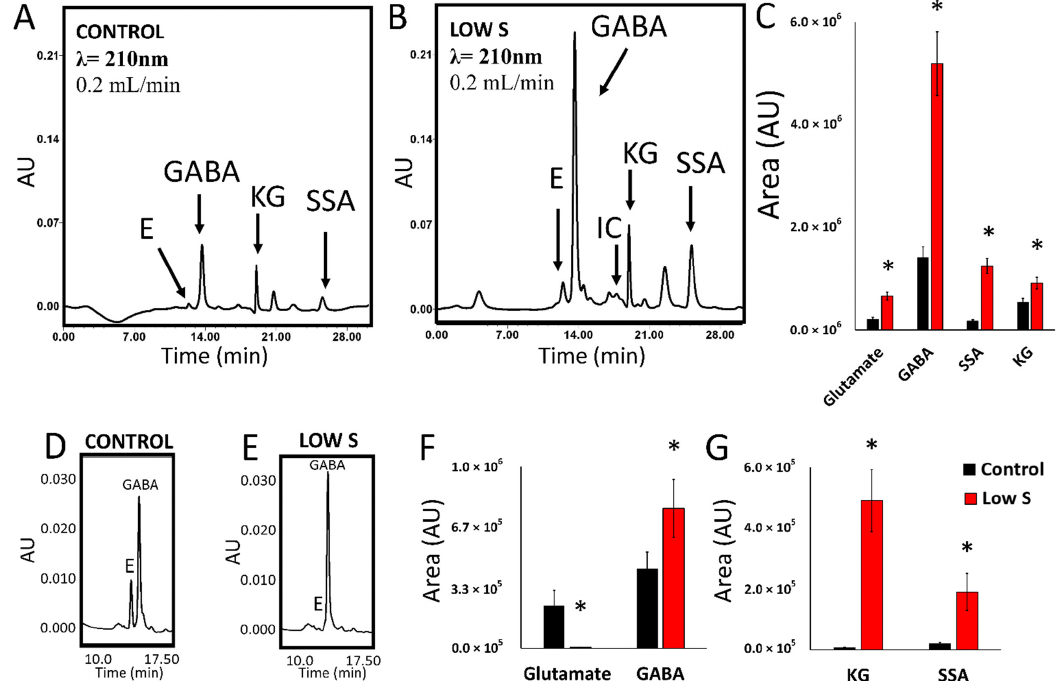
Figure 2. Metabolite profiling in P. fluorescens cell free extract and intact cells in control and sulfur- deficient conditions. ( A ). HPLC chromatogram of a cell free extract from P. fluorescens grown in control conditions. ( B ). HPLC chromatogram of a cell free extract sample from P. fluorescens grown in a media with no added sulfur. Peaks corresponding to glutamate ( E ), isocitrate (IC), γ -aminobutyric acid (GABA), α -ketoglutarate (KG) and succinate semialdehyde (SSA) are shown. ( C ). Quantification of select metabolites in cell free extract samples of P. fluorescens grown in control and sulfur-deficient (Low S) conditions. Enrichment in GABA, SSA and KG is seen in sample from sulfur-deficient grown cells. ( D , E ). HPLC chromatogram of whole cells P. fluorescens control ( D ) and low sulfur ( E ) cells incubated with 10 mM glutamate for two hours. ( F ). Quantification of metabolites in whole P. fluorescens cells grown in control and sulfur-deficient (Low S) conditions fed with 5 mM glutamate and incubated for two hours. ( G ). Quantification of metabolites in whole P. fluorescens cells grown in control and sulfur-limited (Low S) conditions fed with 10 mM succinate, 10 mM HCO 3 − and incubated for two hours. Succinate metabolism leads to enrichment in KG. Data are represented as means ± standard deviation. n = 3, * = p <